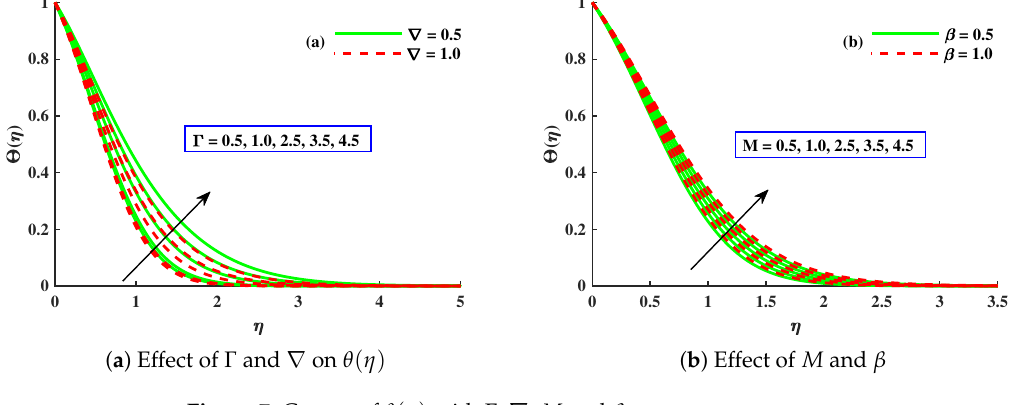
Figure 7. Curves of θ ( η ) with Γ , ∇ , M and β .